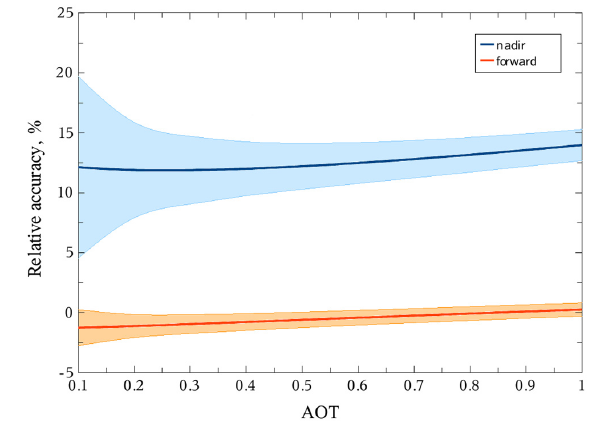
Fig. 5. Relative error of TOA reflectance reconstructed from the BT at 12µm and 3.7µm for the forward (red curve) and nadir (blue curve) views. Filled areas show the sensitivity of the TOA re- flectance at 3.7µm to the AATSR calibration error of ±